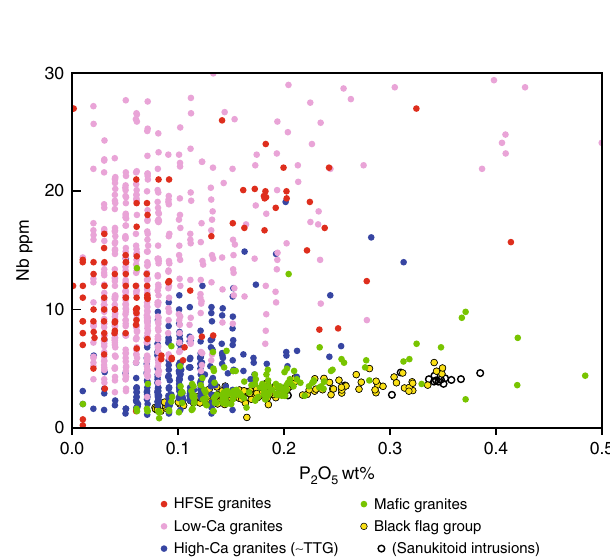
Fig. 5 Compositional comparison between sanukitoids and other granitic rocks of the Eastern Gold fi elds Supertarrane. Variation in Nb concentration with concentrations of P 2 O 5 , comparing sanukitoids (including the volcanic rocks of the Black Flag Group) with granites of the eastern Yilgarn Craton. Granites in the Yilgarn Craton have been divided between two main groups 29 (High-Ca and Low-Ca granites) and two minor groups (high fi eld-strength element (HFSE) granites and ma fi c granites). See Data Availability for the source of geochemical data for the eastern Yilgarn Craton